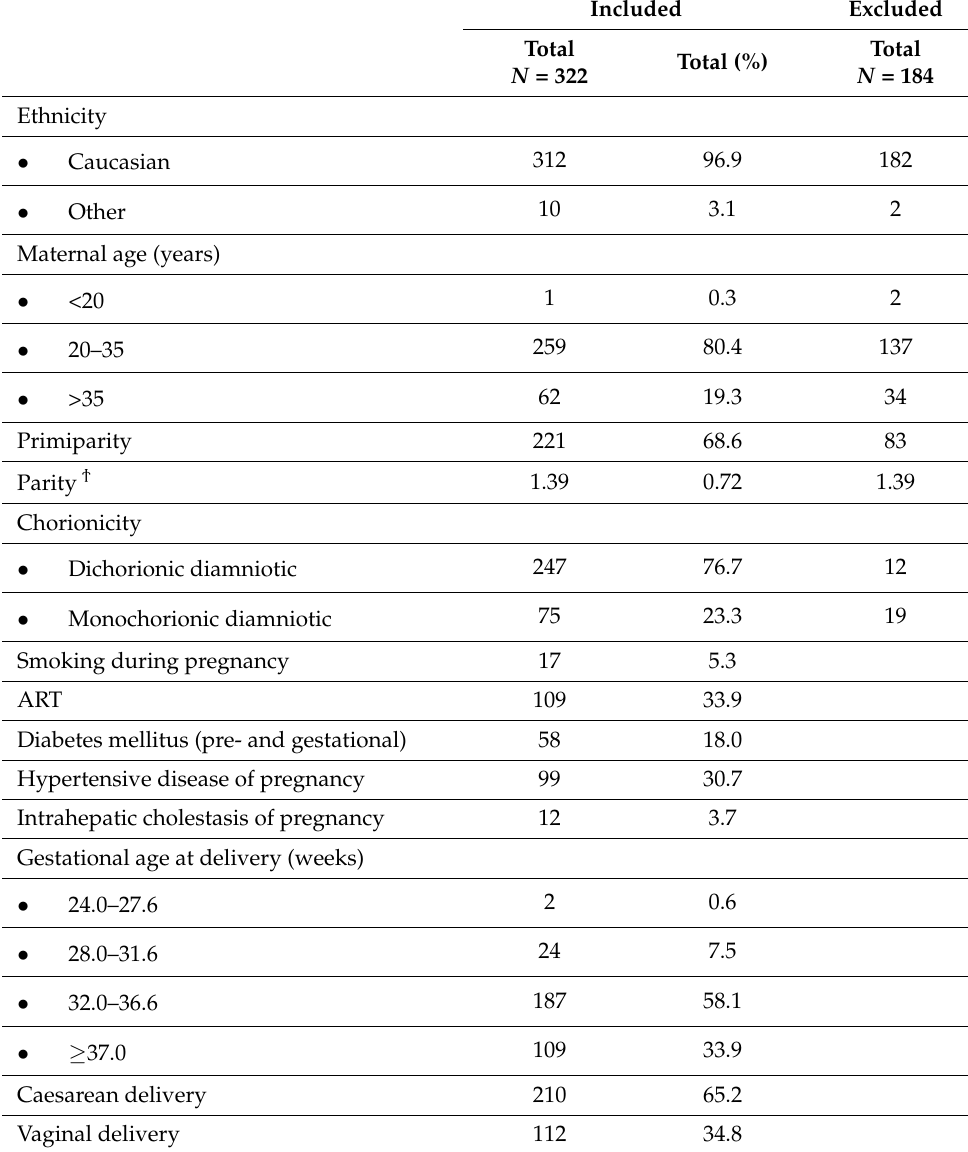
Table 1. Maternal characteristics of the study group.